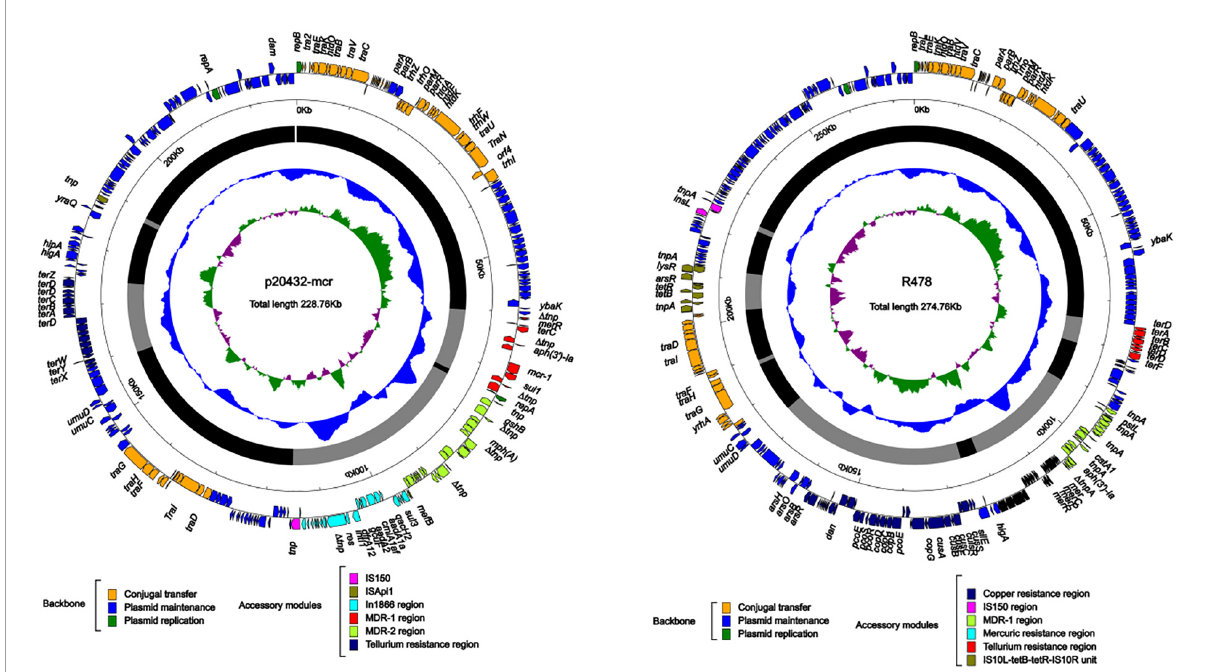
FIGURE8 The complete sequence circular diagram of p20432- mcr and R478. The innermost ring represents (G–C)/(G + C); the blue ring indicates GC content, and the outward depression indicates that the GC content is higher than the mean value. Black area in the outer circle represents the backbone area and gray area represents the accessory modules. The outermost circle shows the distribution of genes represented by colored arrows in the plasmid.